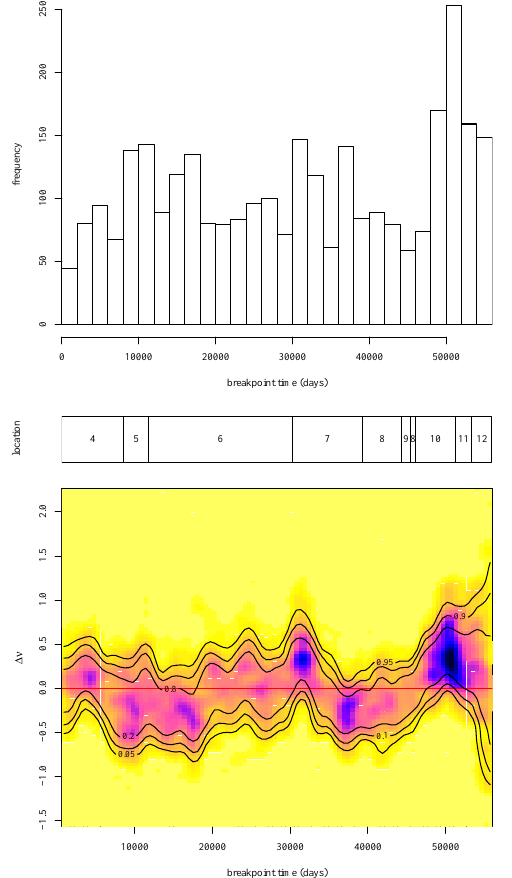
Fig. 4. Upper plot: histogram of posterior simulations of t 0 . Middle plot: positions of the known rain gauge location changes. Lower plot: (color levels) kernel density estimate of the joint posterior dis- tribution of (t 0 ,1ν) ; (black lines) quantiles of the distribution of 1ν conditional on t 0 .